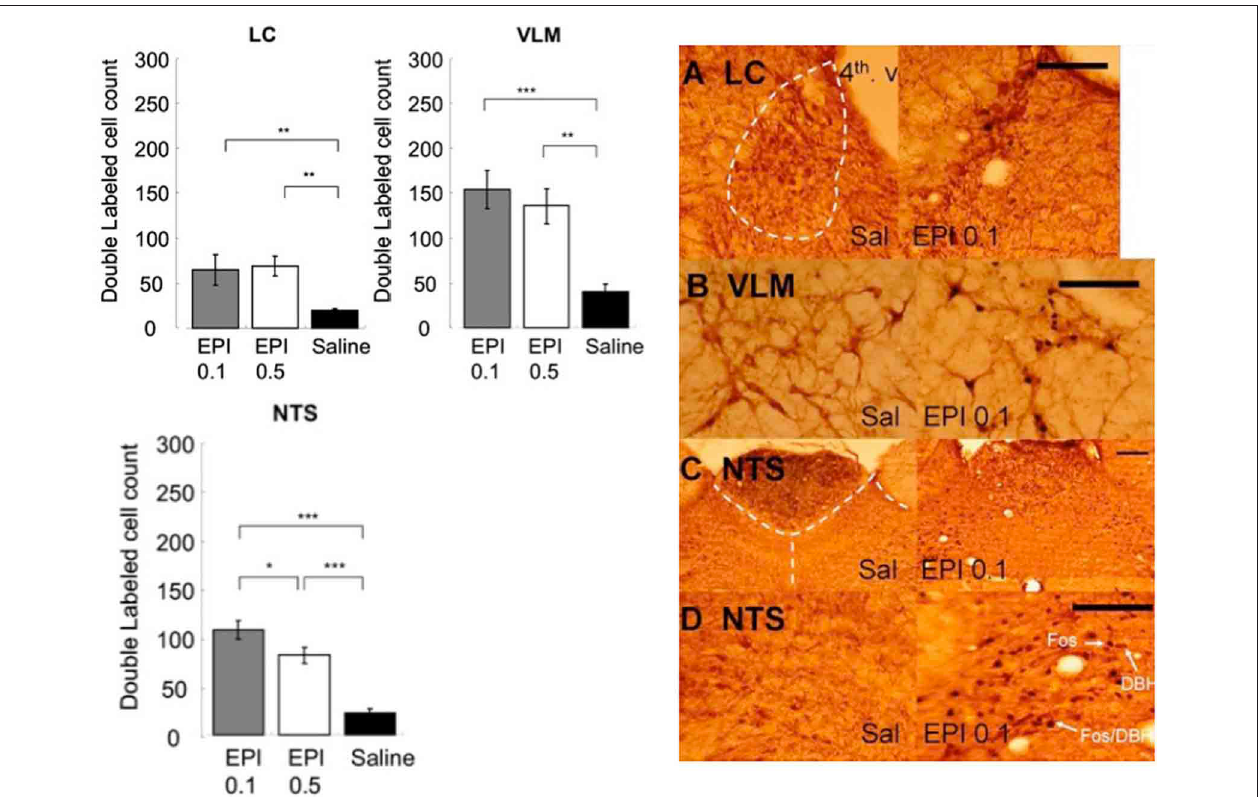
respectively). Photomicrographs of Fos/DBH labeling in the LC ( A), VLM (B), NTS (C,D) following saline or epinephrine injection (0.1mg/kg). Scale bar = 200um. (4 th v.: the fourth